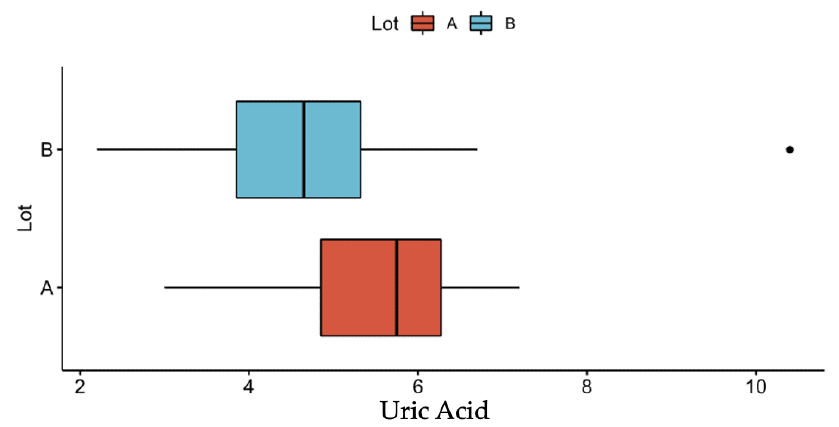
Figure 9. Median serum uric acid value in patients with pancreatic cancer (group A) vs. patients with chronic pancreatitis (group B).